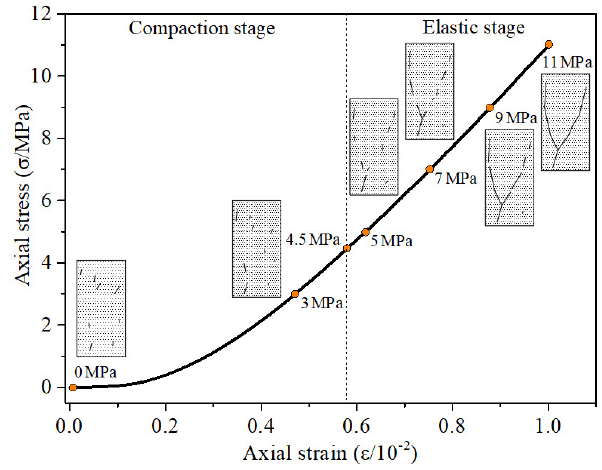
Figure 13. Fracture evolution process of coal sample.